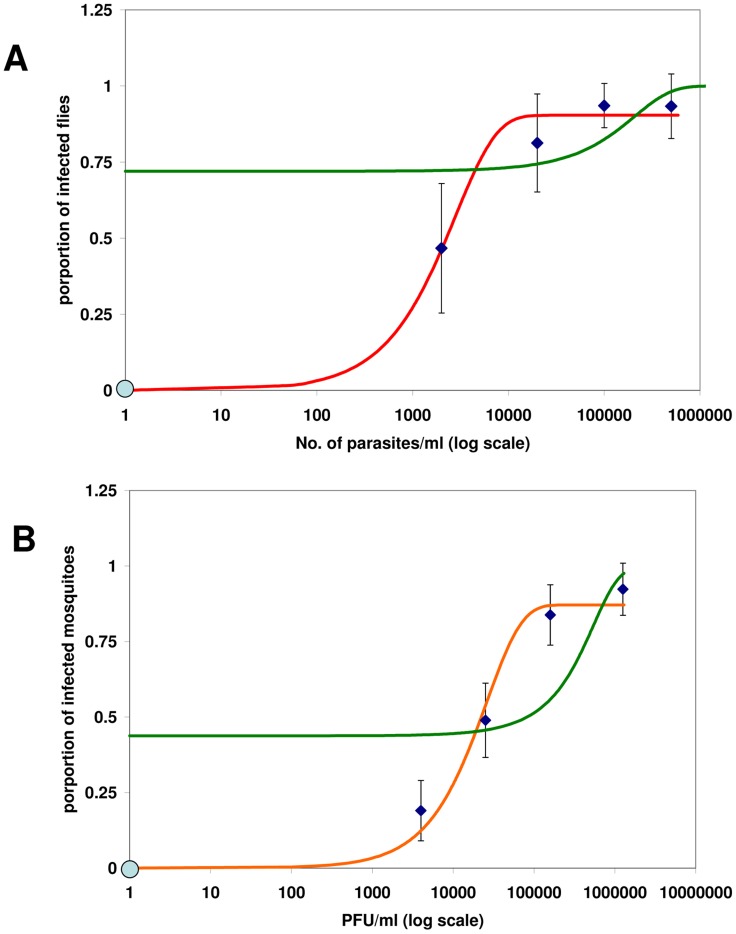
The infectiousness of blood with different parasite concentrations (parasitemias).We fitted the model (equation 4) and logistic function (y = 1/(1+exp[-λ1−λ2x])) to two different VBD set of results by maximum likelihood estimation (Nelder-Mead method) of the model parameters λ1 and λ2. The error bars in the proportion of infected vectors (y axis) were calculated as 95% confidence intervals of the respective binomial distribution. The origin in both panels (marked in blue) was taken as a data point, since we assume that a vector cannot be infected by uninfected blood. In red – our model fit, in green – logistic regression (A) The fitting results to data on VL [6]: our model: λ1 = 0.9037, λ2 = 3.58*10−4, logistic regression:λ1 = 0.9434, λ2 = 6.024*10−6 (B) The fitting results to data on Chikungunya [25]: our model: λ1 = 0.8712, λ2 = 3.82*10−5, logistic regression: λ1 = 0.2505, λ2 = 3.0482*10−6. PFU = Plaque-Forming Unit. Note that our model fits all data points within their confidence intervals. However, the logistic function is unable to fit the data points either for low parasitemia values (since it is always different than zero, thus the origin never belongs to its image), or for high parasitemia values (since it always approaches 1 for x→∞, although certain proportion of vectors can never be infected [17], [18], [19]).